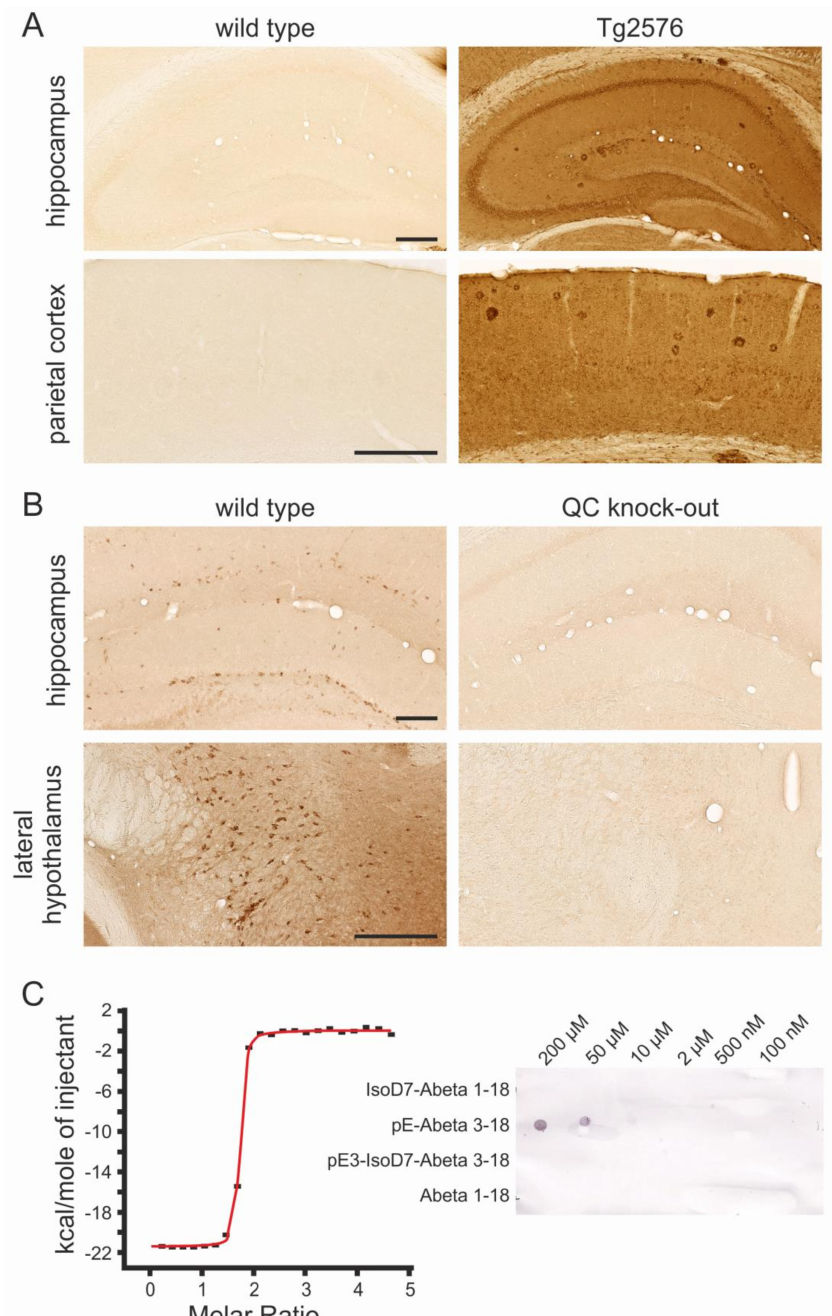
Figure 2. Demonstration of the specificity of antibodies used in this study. ( A ) The monoclonal rat anti-hAPP antibody 1D1 labeled neurons and amyloid plaques in hAPP-transgenic Tg2576 mouse brain as shown for the hippocampus and parietal cortex ( right ), whereas this labeling was lacking in corresponding wild type mouse brain sections ( left ). ( B ) The specificity of the goat anti-QC antiserum is demonstrated by marked labeling of hippocampal interneurons and of neurons in the lateral hypothalamus of wild type mice ( left ), which is absent in QC knock-out mouse brain sections ( right ). Scale bars in ( A , B ) represent 200 µ m. ( C ) The mouse monoclonal anti-pE-Abeta antibody J8 detects pE-Abeta3-18, but not Abeta1-18 or isoAsp7-modified Abeta peptides spotted onto nitrocellulose membranes by dot blot analysis ( right ). Isothermal titration calorimetry revealed a K d value of 1.6 nM for J8 towards pE-Abeta ( left